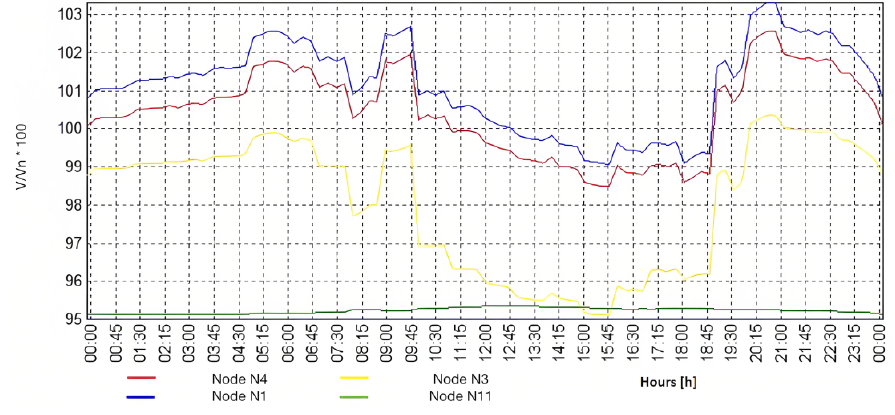
Figure 22. Voltage profile at sensible